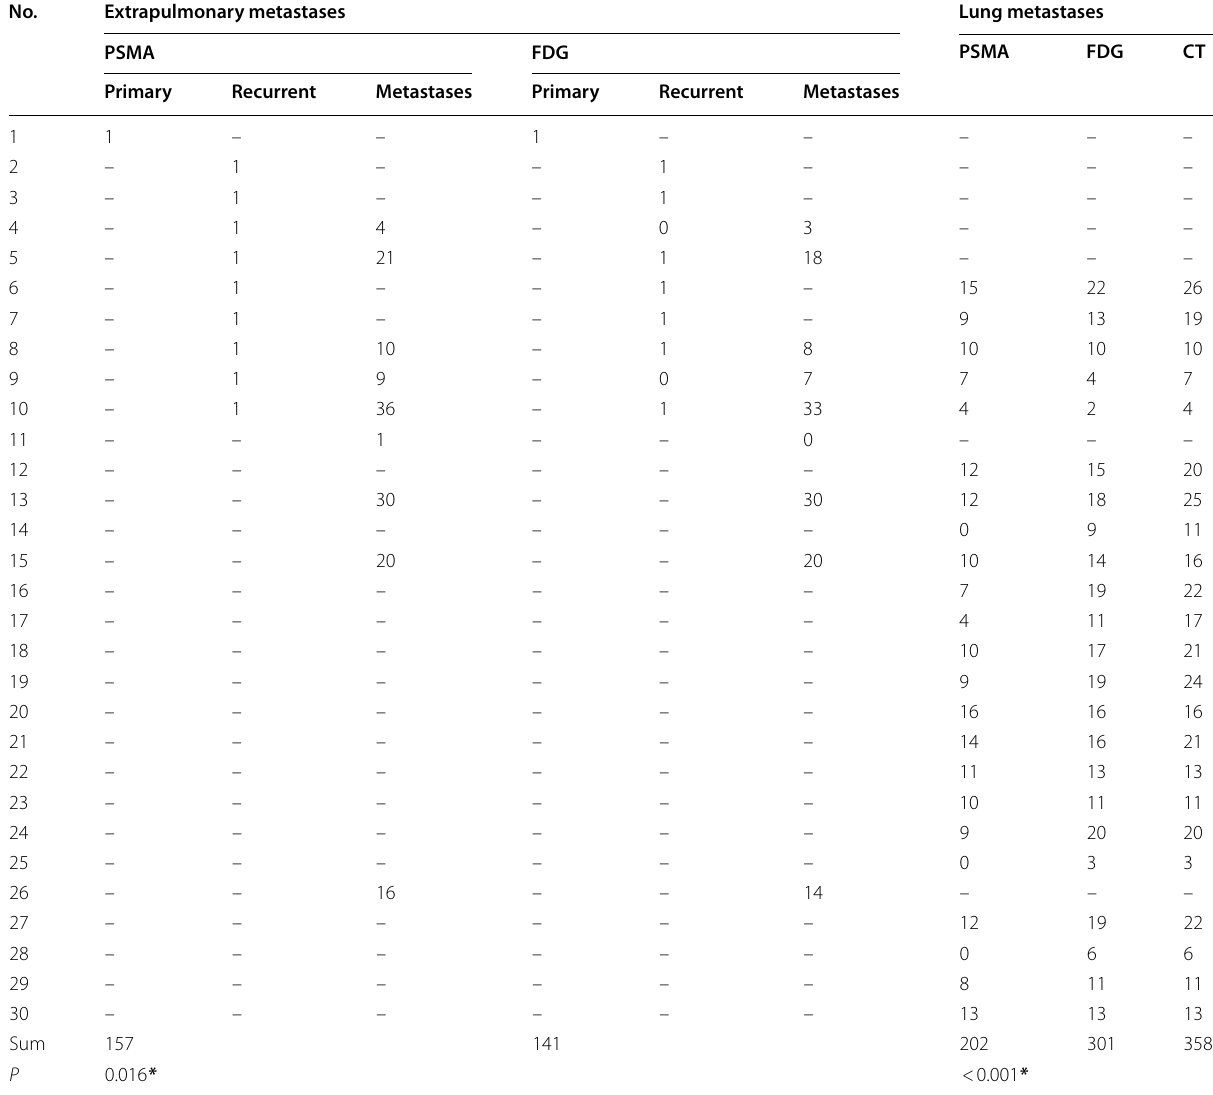
Table 2 Number of PET-positive lesions detected on 68 Ga-PSMA-617 and 18 F-FDG PET/CT